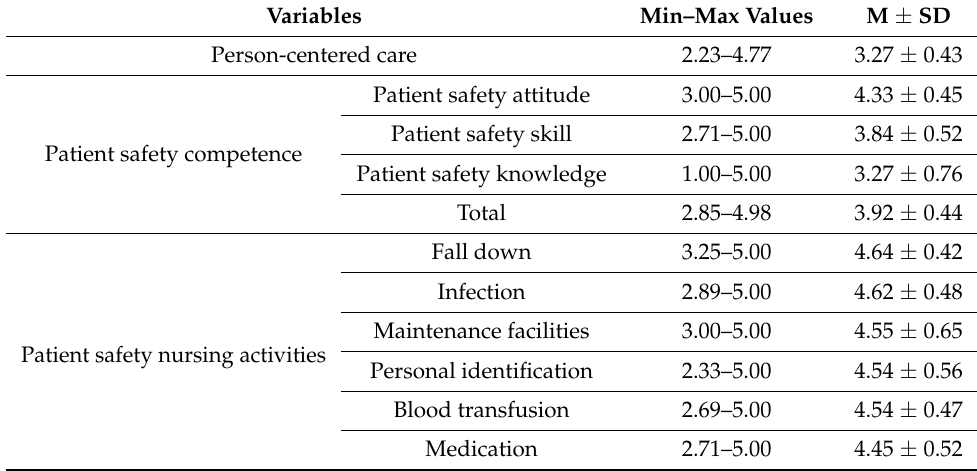
Table 2. Degree of person-centered care, patient safety competence, and patient safety nursing activities ( N =